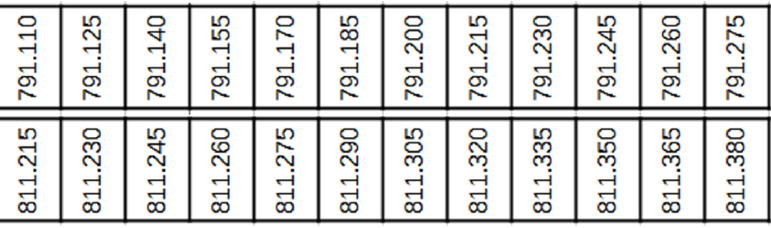
Figure 11. Subcarriers of NB-IoT signals of other network operators.